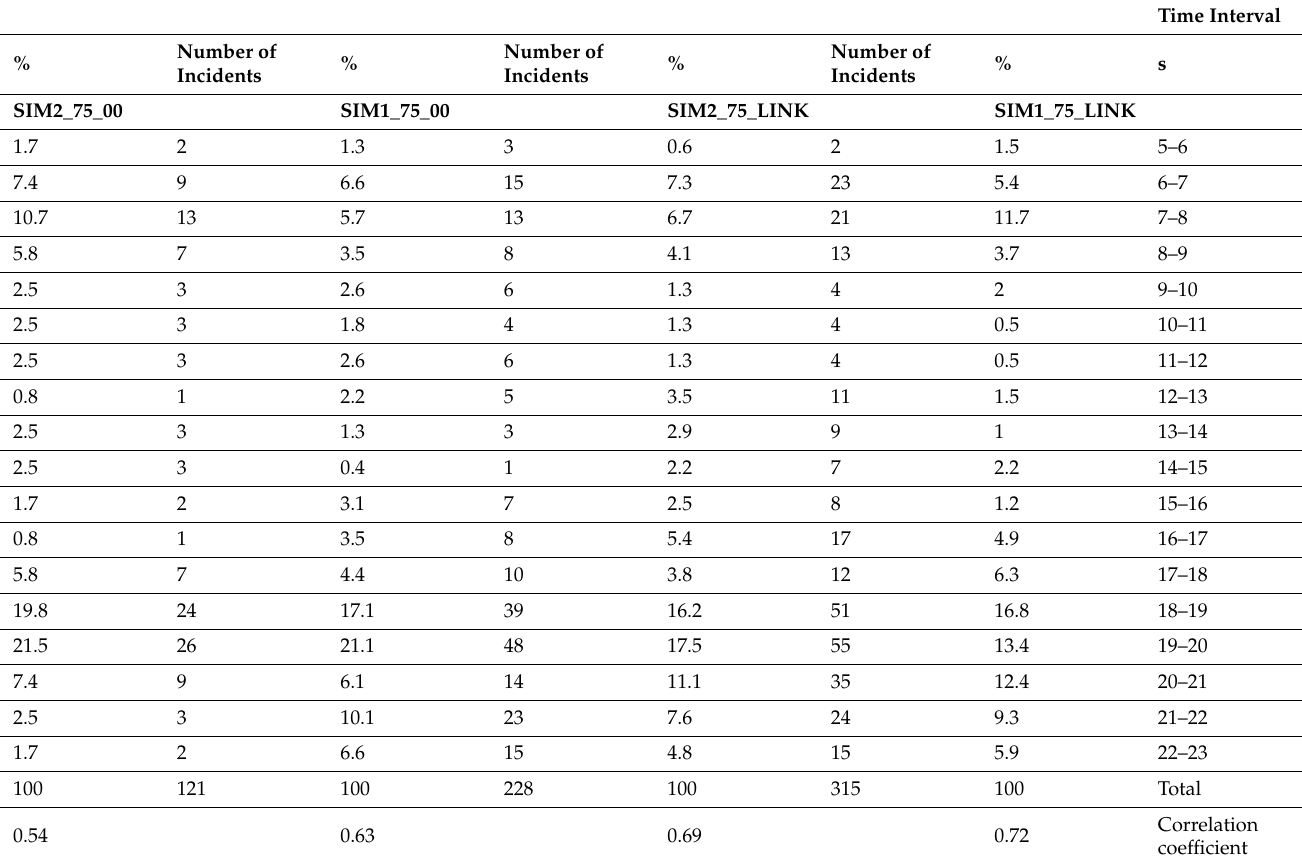
Table 4. The correlation between the inflow of wastewater to the pumping well and the hourly distribution of the occurrence of simultaneous operation expressed in percentage.